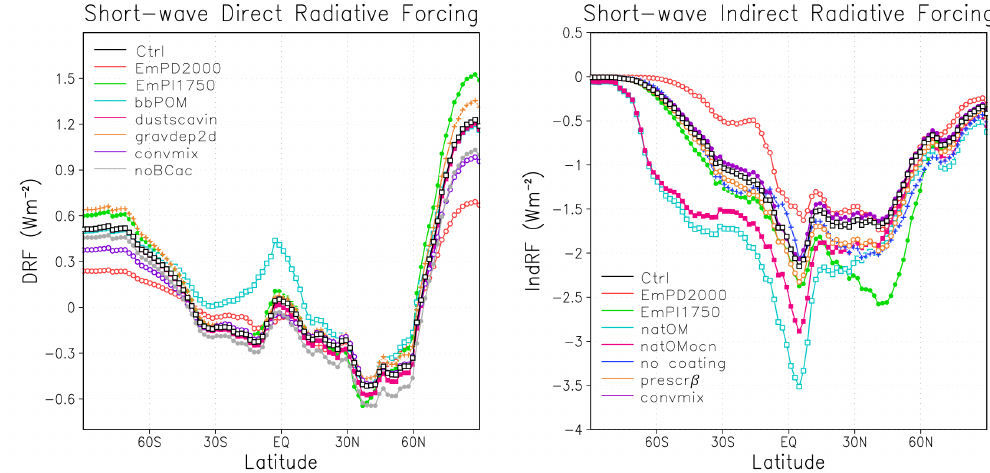
Fig. 12. Modeled annual, zonally averaged direct (left) and indirect (right) top of the atmosphere short-wave radiative forcing (Wm − 2 ) for the Ctrl experiment (year 7) and the sensitivity tests with largest impacts on aerosol